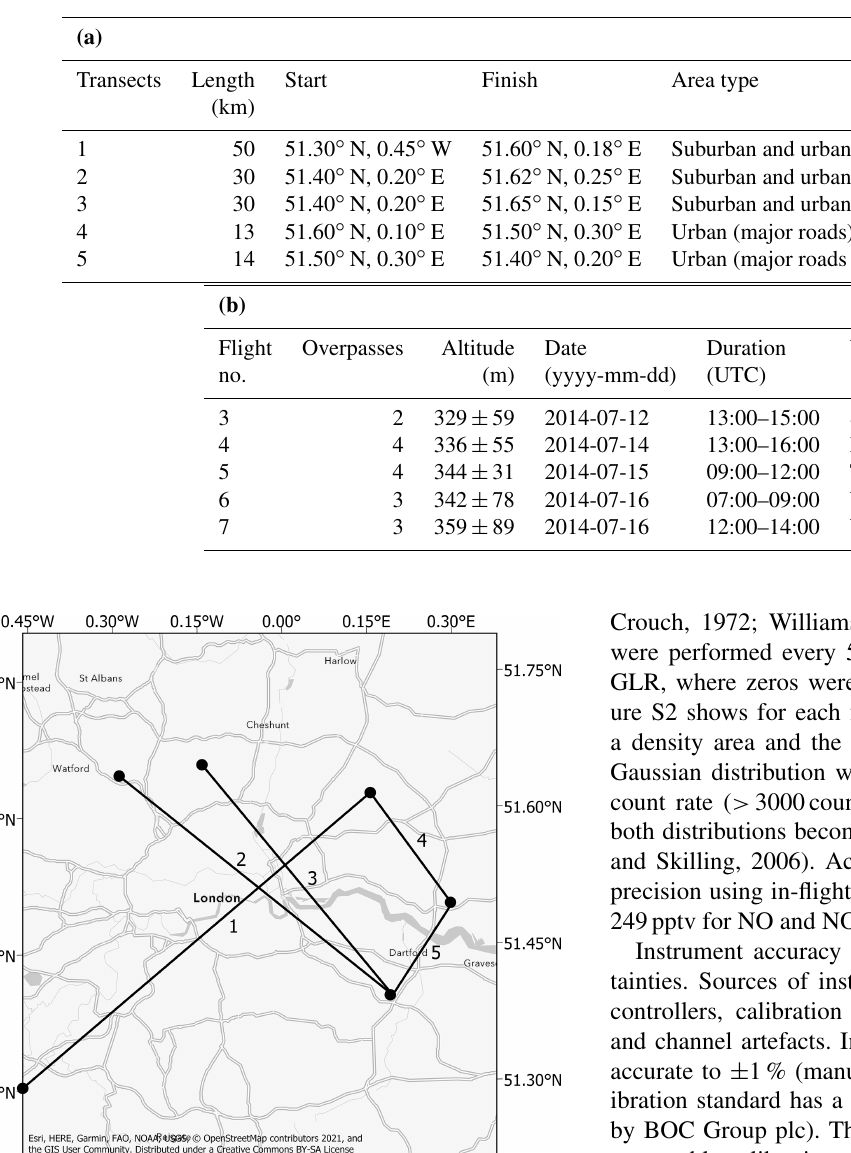
Table 1. (a) Individual flight transect information. (b) Flight information outlining the time each flight occurred, the number of complete London overpasses and the altitude range.